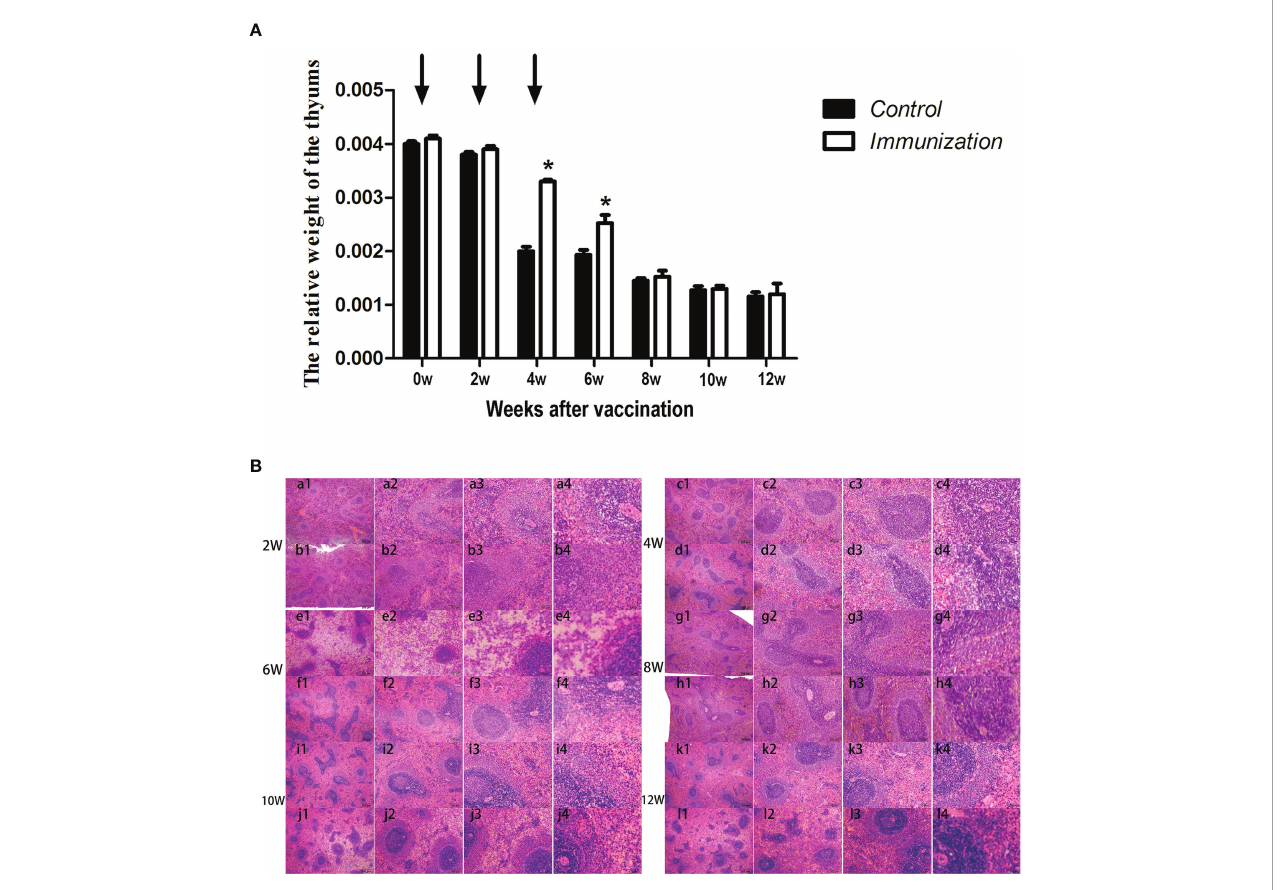
FIGURE 5 (A) Mean (± SEM) of the relative weight of the thymus in the gonadotropin-releasing hormone (GnRH) immunization group (n = 35) and control group (n = 35). Arrows indicate the primary vaccination and subsequent boosters. * Indicates a signi fi cant difference ( P < 0.05). (B) Histopathological observation of the thymus of the control group (a, b, e, g, i, k) and gonadotropin-releasing hormone (GnRH) immunization group (b, d, f, h, j, l). All observations were performed on samples taken from 4 week old rats after fi rst immunization. Numbers 1, 2, 3, and 4 represent a magni fi cation of 40, 100, 200, and 400 times,